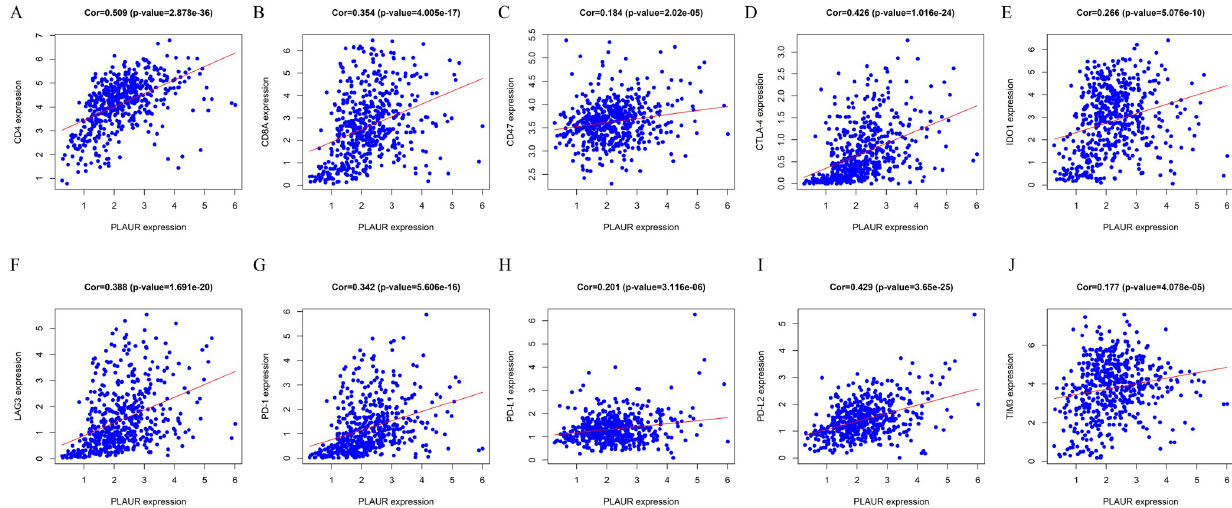
Fig 7. Correlation analysis of PLAUR expression and immune checkpoint gene expression.